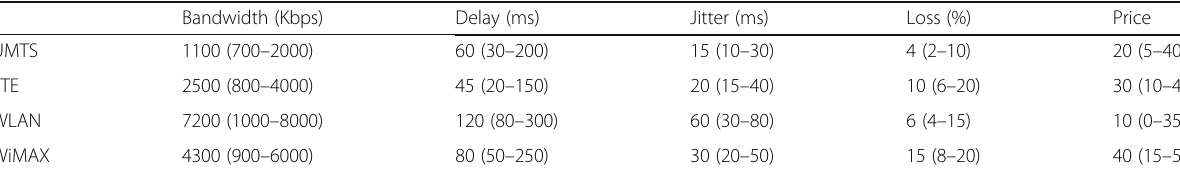
Table 18 Network attribute parameter value settings